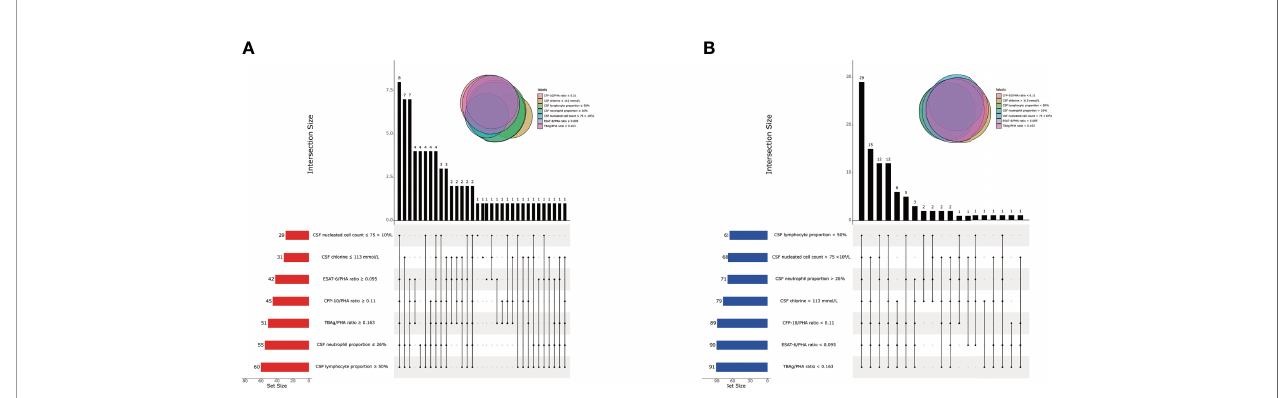
FIGURE 4 | The cross set between various indicators in TBM group and BM group. (A) Upset plot showing the cross set between various indicators in TBM group. (B) Upset plot showing the cross set between various indicators in BM group. TBM, tuberculous meningitis; BM, bacterial meningitis; CSF, cerebrospinal fl uid; ESAT-6, early secreted antigenic target 6; CFP-10, culture fi ltrate protein 10; PHA, phytohemagglutinin; TBAg, tuberculosis-speci fi